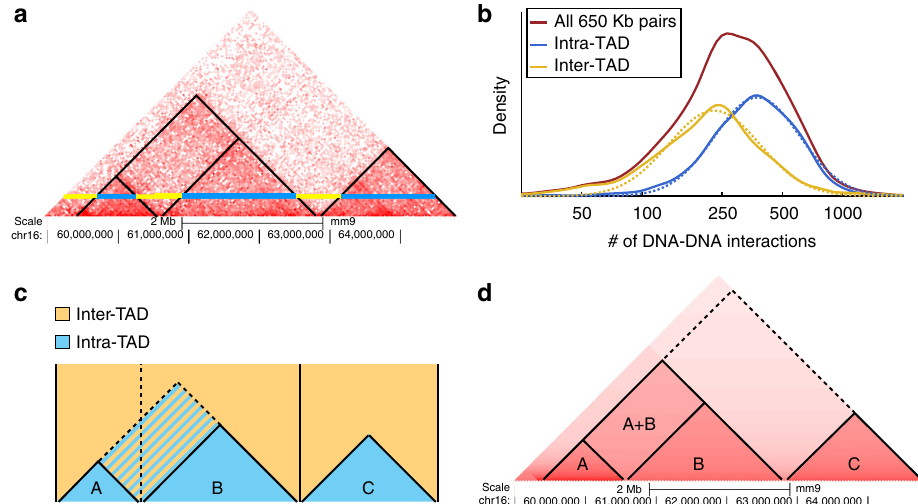
Fig. 1 Overview of the PSYCHIC algorithm. a Example of Hi-C interaction map (rotated in 45°), from mouse cortex (chr16, 59 – 65 Mb) 25 . Blue and yellow horizontal lines correspond to DNA – DNA pairs, 650 Kb apart, within and across domains. b Histograms show the empirical abundance of these DNA – DNA interactions, either within domains (blue) or across domains (yellow), and demonstrate the enrichment of intra-TAD interactions. Dotted lines show a log- Normal distribution fi tted to these empirical data. c . PSYCHIC fi rst uses a two-component probabilistic mixture model to estimate the number of intra-TAD (blue) and inter-TAD (yellow) DNA – DNA interactions. For example, shown is segmentation into three domains A – C (delineated by vertical lines). An alternative segmentation, where A and B domains are uni fi ed now consider the striped rectangle as intra-TAD. PSYCHIC uses a log-posterior ratio score with a Dynamic Programming algorithm to identify the optimal (Viterbi) segmentation of the chromosome into domains. d . PSYCHIC then iteratively merges similar neighboring domains (here, A + B) into hierarchical structures. For example, dotted lines marks a possible 2 nd – order merge between the merged (A + B) domain and domain C. PSYCHIC then fi ts a bi-linear power-law model for each TAD or merge to reconstruct a domain-speci fi c background model (shown by different shades of red). This allows for the identi fi cation of over-represented DNA – DNA pairs, including putative promoter – enhancer